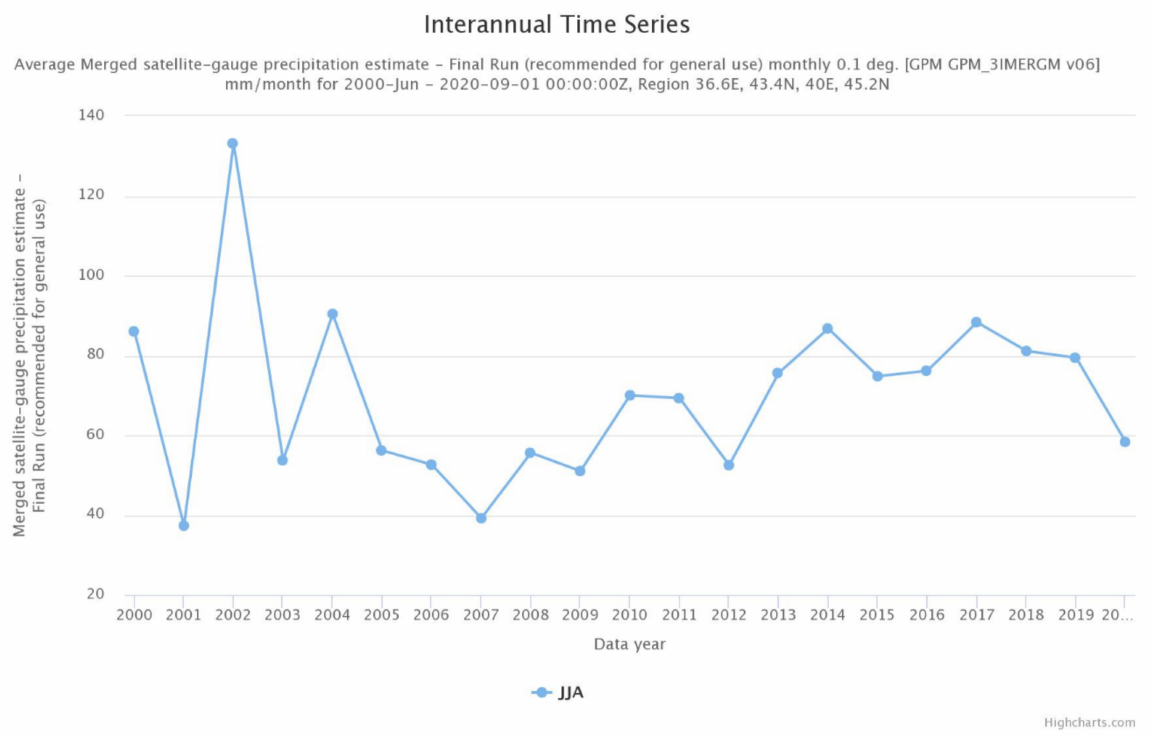
Figure 10. Interannual variability of atmospheric precipitation (mm/month) in the northeastern Black Sea in summer from 2000–2020 based on the GPM_3IMERGM v06